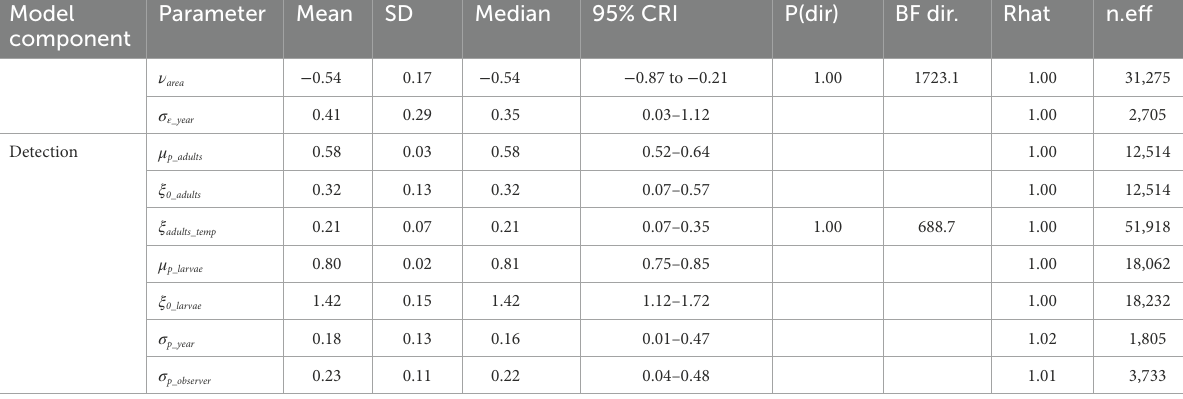
(Table 4; Figure 5). Colonization probabilities were higher in waterbodies without fish than waterbodies with fish, regardless of seasonality, for sierran treefrogs and Sierra Nevada yellow-legged frogs (Tables 2, 3; Figure 5). In addition to weather variables, site colonization probability for Sierra Nevada yellow-legged frogs was negatively related to site area (Table